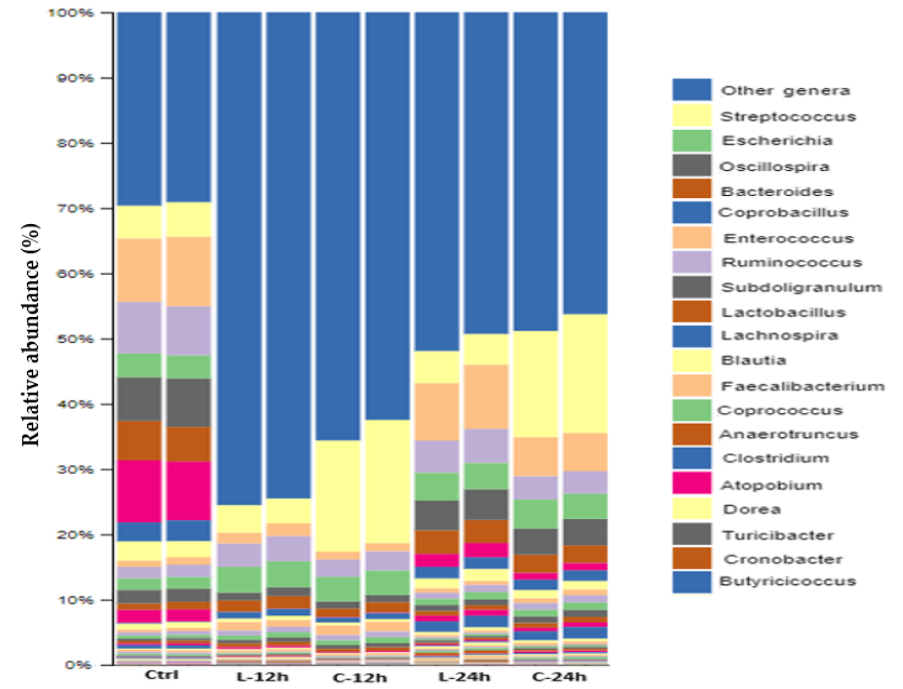
Figure 7. Effect of chicory and lucerne on the relative abundance of microbial genera. Ctrl: control; L-12 h: 12-h fermentation with lucerne; L-24 h: 24-h fermentation with lucerne; C-12 h: 12-h fermentation with chicory; C-24 h: 24-h fermentation with chicory.